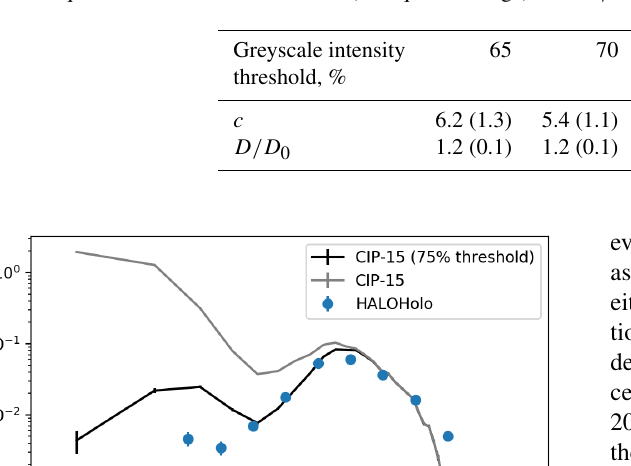
Table 2. Median (interquartile range) depth of field c value (Eq. 1) for 1060 ice crystal images using various greyscale intensity thresholds and circle equivalent diameter. The median (interquartile range) ratio D/D 0 for Z d <c is also given.